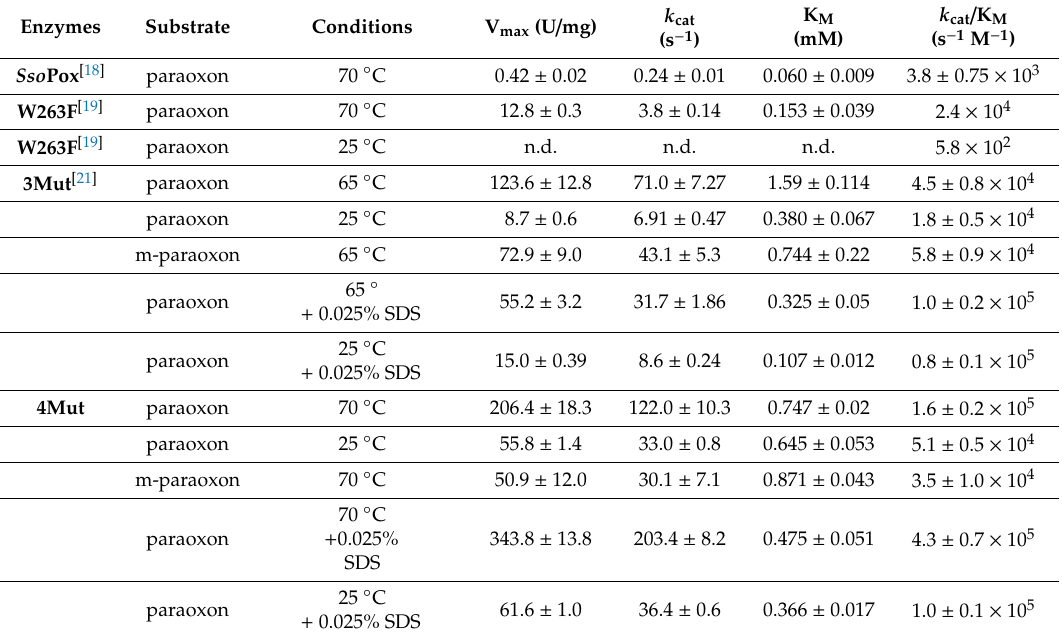
Table 2. Kinetic parameters of Sso Pox and its